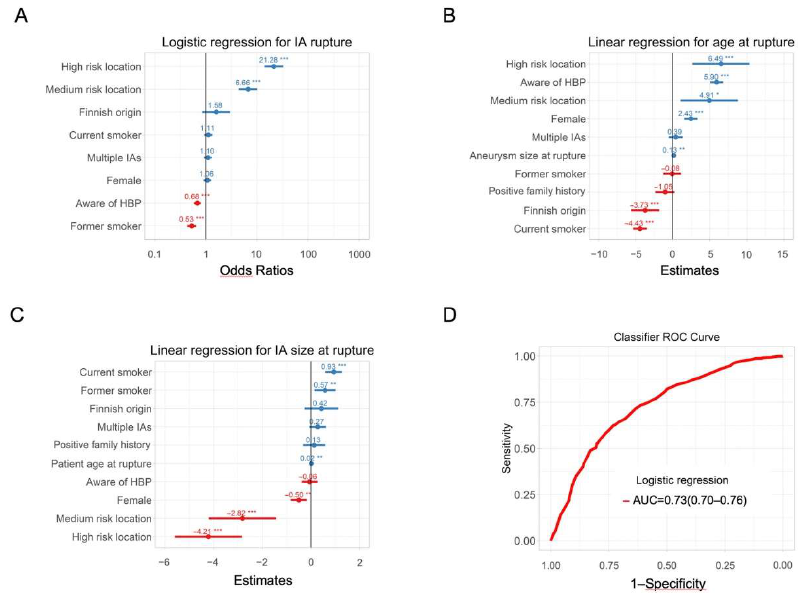
Figure 6. Importance of phenotypic markers for the likelihood of being diagnosed with a ruptured IA. ( A ) MLoR for diagnosis of aSAH. ( B ) MLiR for patient’s age at rupture and ( C ) MLiR for IA size at rupture. * p < 0.05, ** p < 0.01, *** p < 0.001. ( D ) ROC curve of the MLoR.